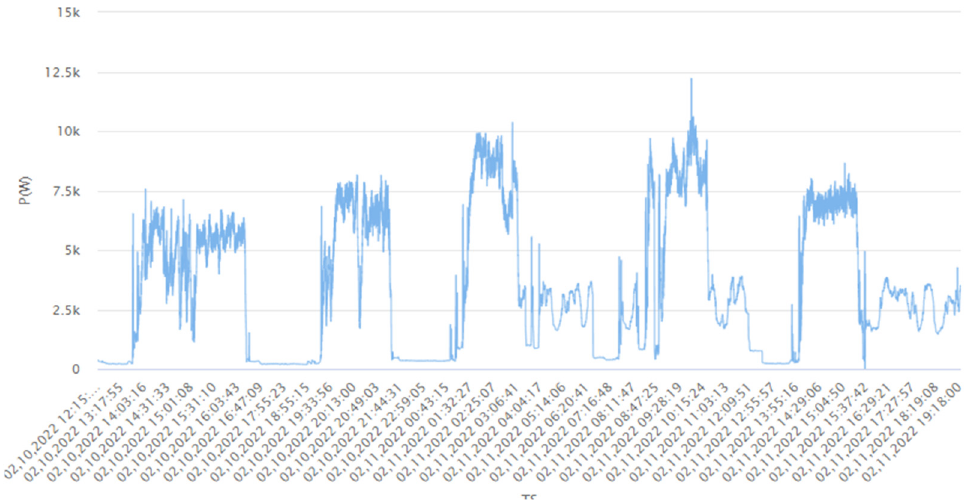
Figure 2. Energy consumption behavior during 24 h .